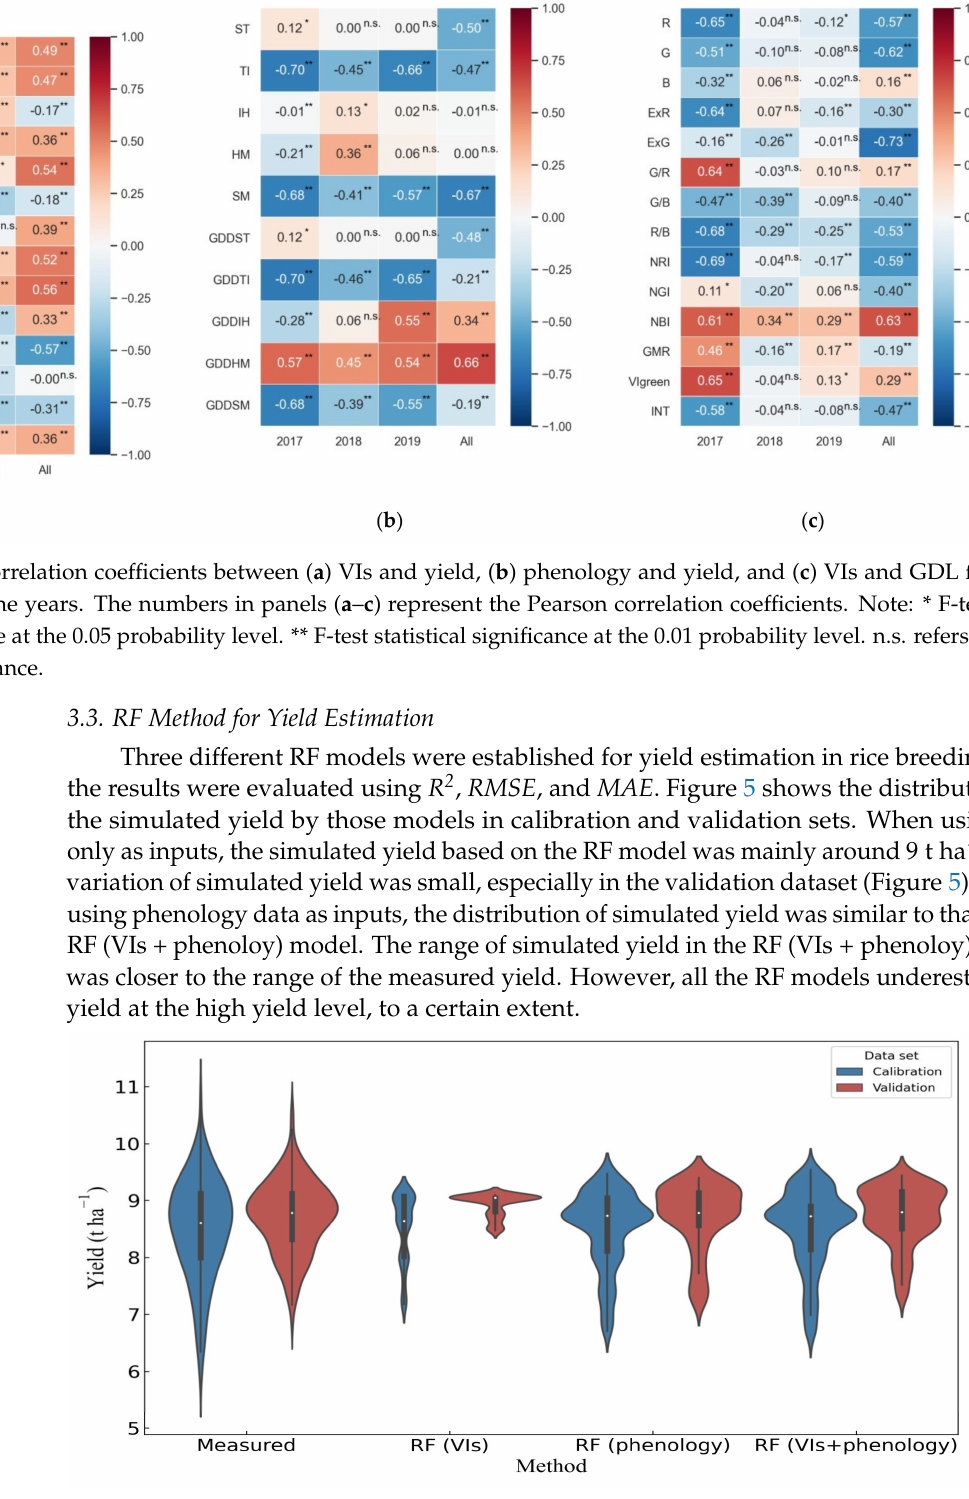
Figure 5. The distribution of measured yield and simulated yield of three RF models in calibration (747 plots in 2017 and 2018) and validation (315 plots in 2019)